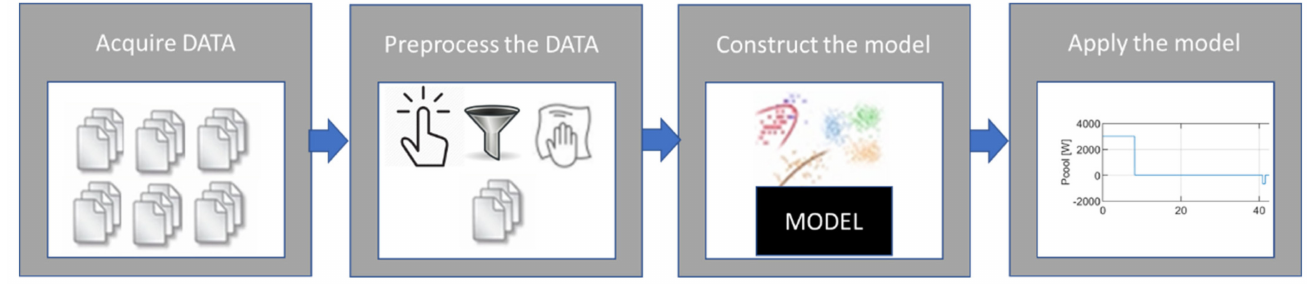
Figure 5. Roadmap of the training process of a supervised learning